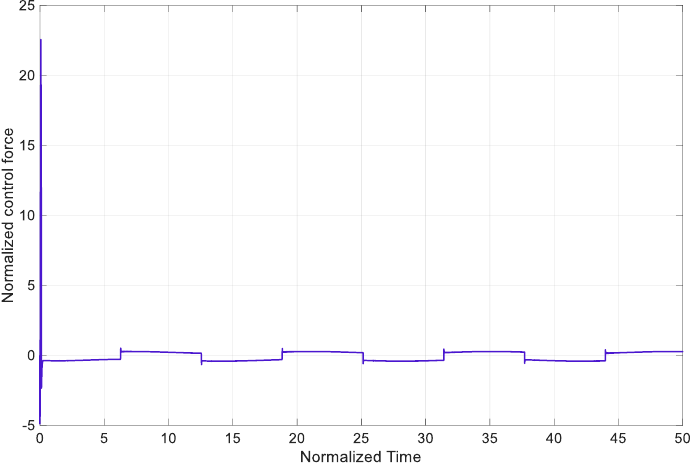
Figure 7. The control input for the CNT with uncertain parameters and unknown disturbance.